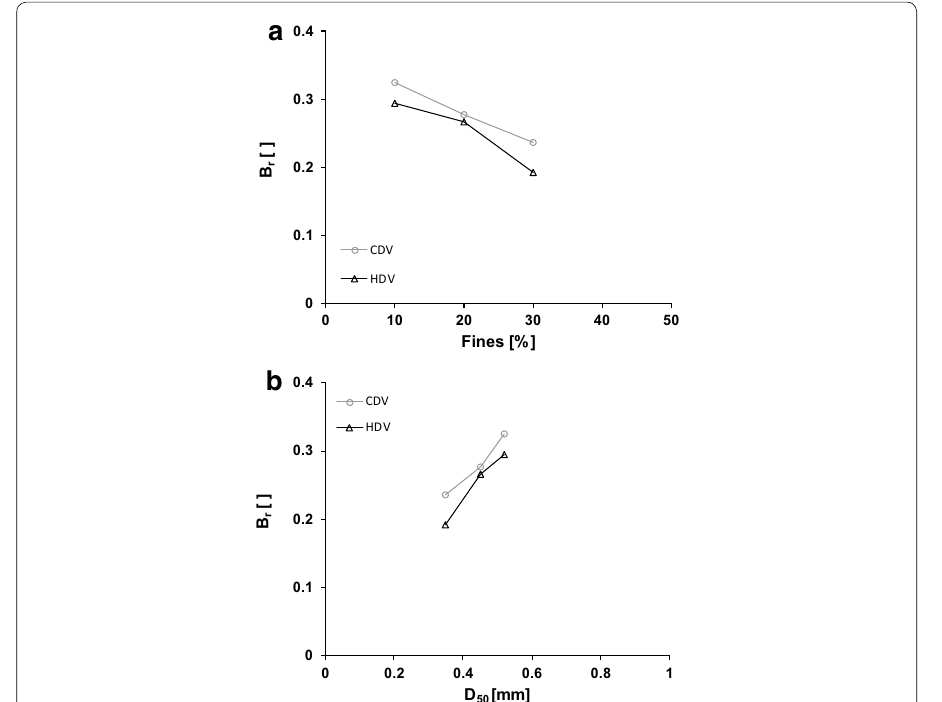
Fig. 14 Variation of particle breakage with grading descriptors. a Fines content and b mean particle size